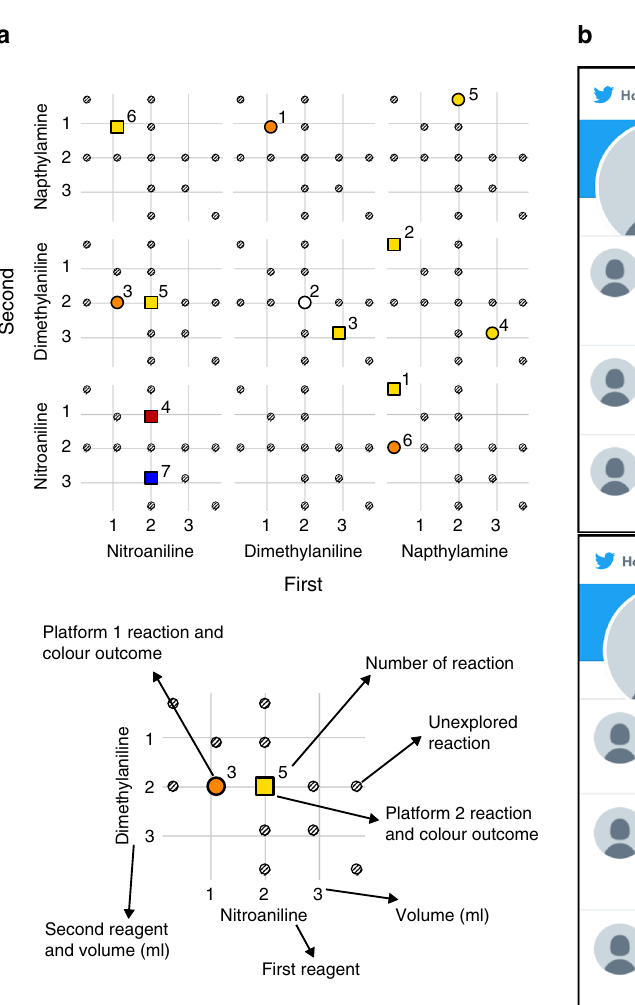
Fig. 4 Platform collaboration. a Example of the organic space exploration managed by two collaborating units (squares and circles). b Twitter accounts used for real-time data